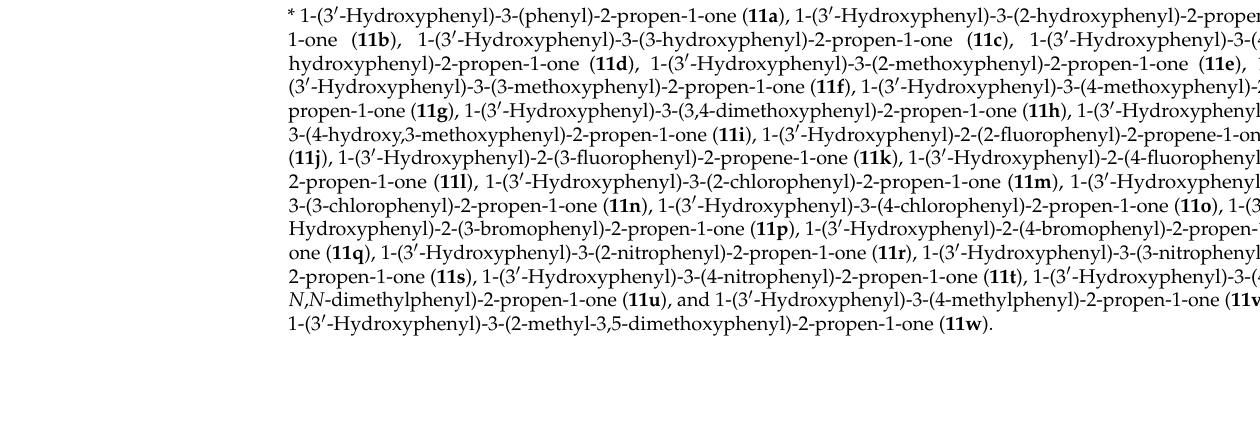
Table 19. Antibacterial activities of tested chalcones against B. bronchiseptica .